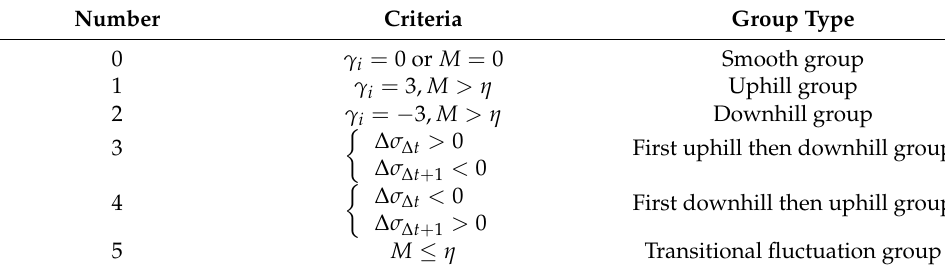
Table 1. Wind power dynamic clustering